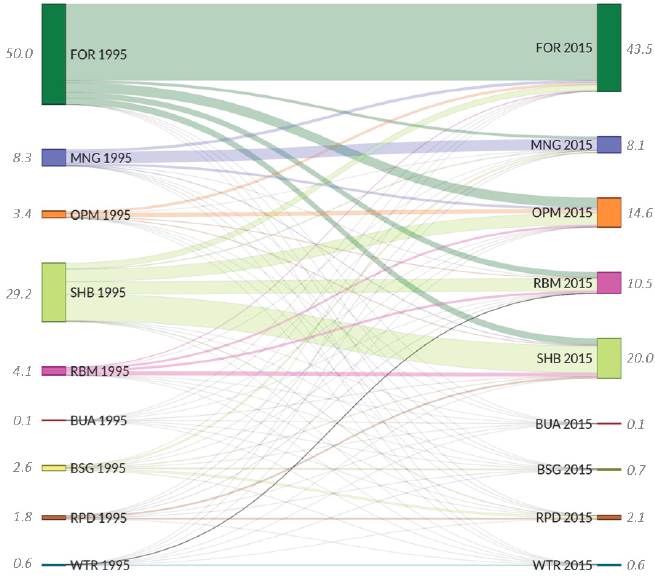
Figure 4. Sankey diagram of the land cover transitions from 1995 to 2015 in Tanintharyi Region, Myanmar. Numbers beside boxes indicate percentage of land cover type to total landscape.